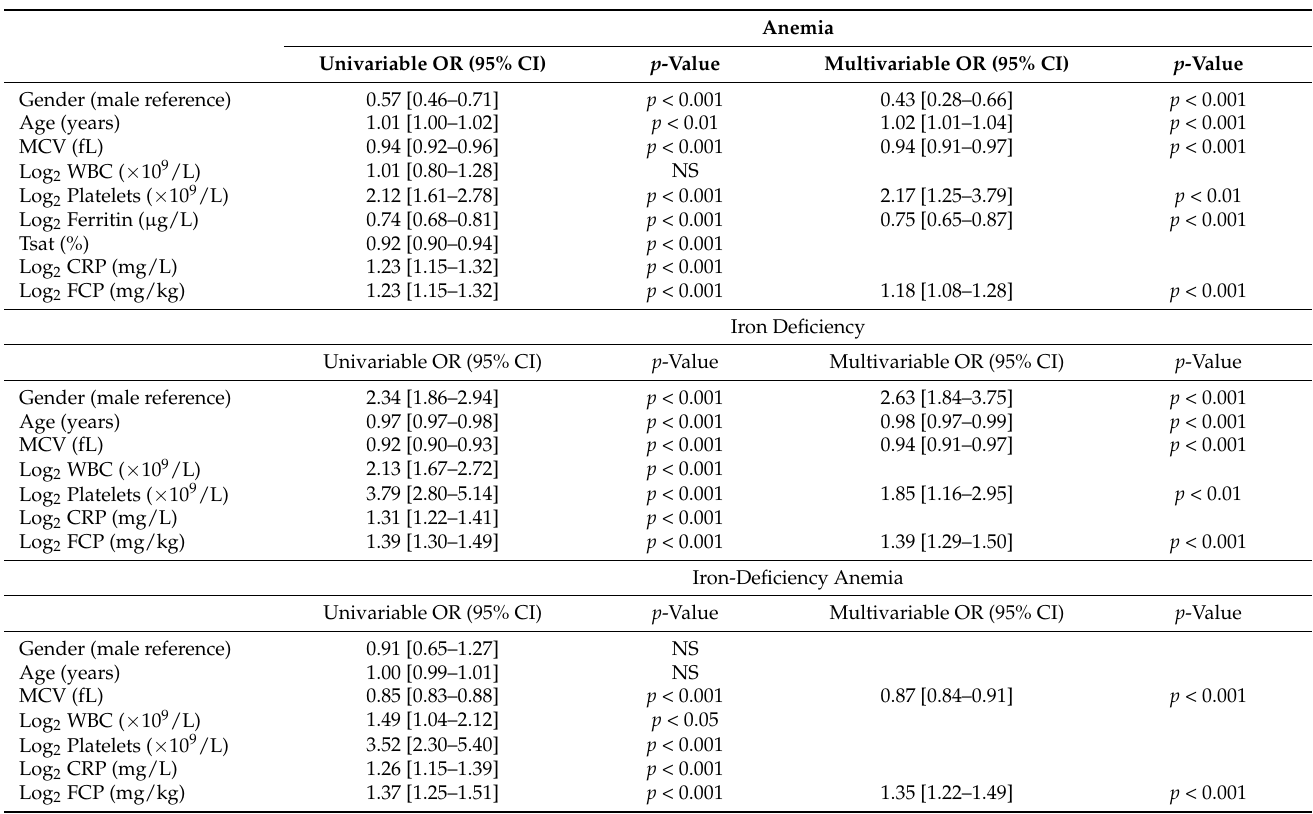
Table 3. Risk factors for anemia, iron deficiency, and iron-deficiency anemia in patients with Inflam- matory Bowel Disease.